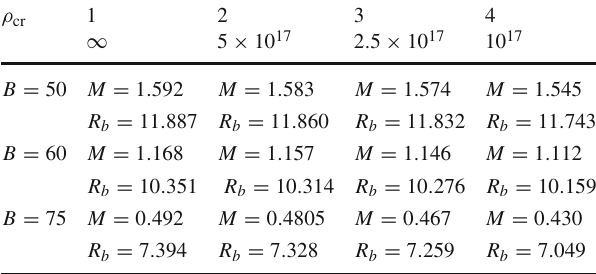
Fig. 7 Mass–radius relation for compact objects with ECT-inspired corrections and MIT-bag equation of state B = 50 MeV / fm 3 . The solid curve (1) shows the purely relativistic case. The dashed curve (2) is obtained for ρ cr = 5 × 10 17 g / cm 3 , the dotted curve (3) is obtained for ρ cr = 2 . 5 × 10 17 g / cm 3 , the dash-dotted curve (4) is obtained for ρ = 10 17 g / cm 3 cr Table 4 Comparison of the radii of ECT-inspired compact objects with MIT-bag model EoS and central density ρ 0 = 6 . 5 × 10 14 g / cm 3 for different values of the bag constant B in units MeV / fm 3 . Masses are in units of solar masses, radii are in km, densities are in g / cm